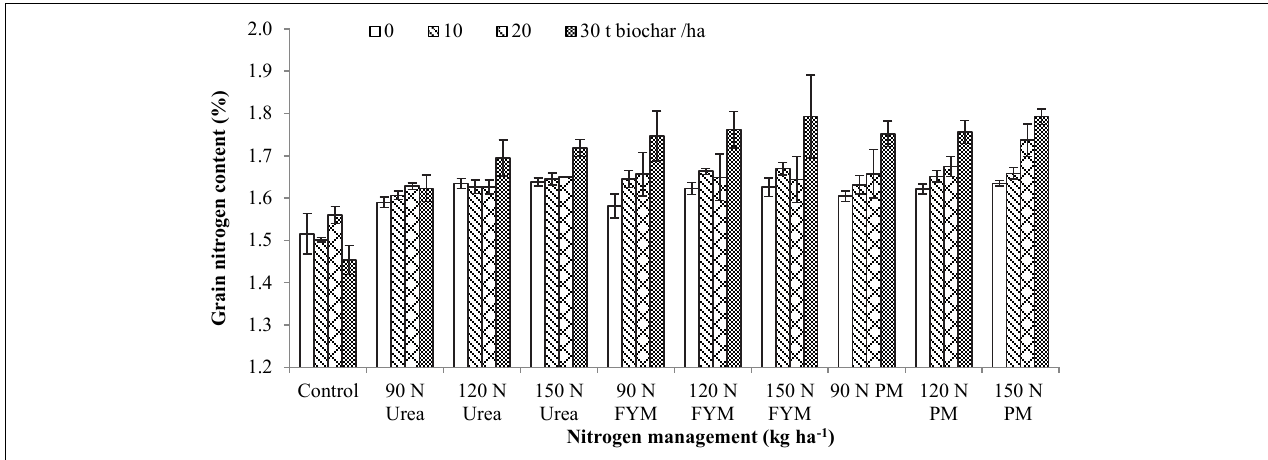
FIGURE 4 | Interactive effect of biochar and N levels applied from different sources on grain nitrogen content of wheat. Bars on the graph denote SE of mean ( n = 3). FYM, farmyard manure; PM, poultry manure.